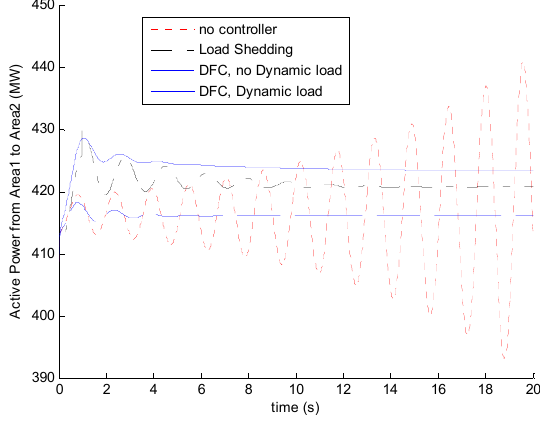
Figure 3. The tie-line active power (MW) versus time (s) with a small disturbance for cases (i) no controller; (ii) load shedding control; (iii) DFC without dynamic loads; (iv) DFC considering dynamic